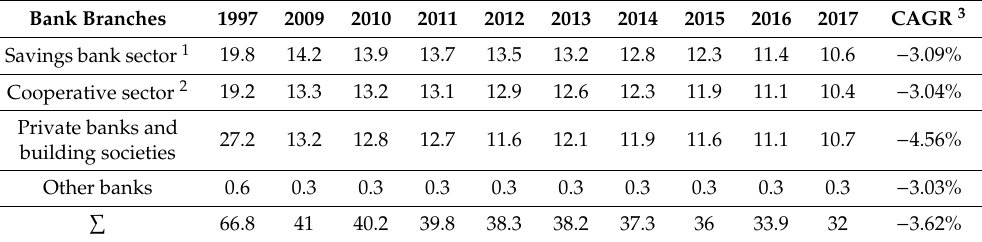
Table 1. Bank branches by bank groups 1997–2017 in